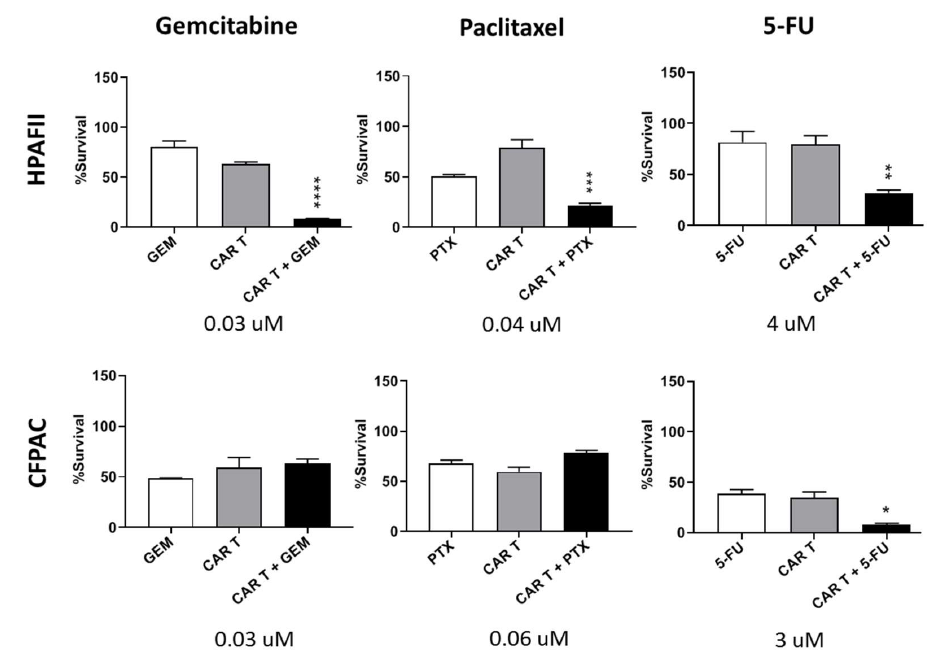
Figure 8. tMUC1-CAR T cells work synergistically with common chemotherapy drugs to kill resistant PDA cells. Percentage survival of two resistant PDA cells, HPAFII and CFPAC, treated with combination of CAR T and chemotherapy drugs. HPAFII and CFPAC were exposed to gemcitabine, paclitaxel, or 5-FU for 24 h at indicated concentrations, then co-cultured with mock or CAR T cells at T:E ratio of 1:10. The survival level was measured using MTT assay and data was normalized to mock T. Student’s t -test comparing CAR T + drug to CAR T alone group, * p < 0.05, ** p < 0.0021, *** p < 0.0004, **** p < 0.0001. Error bars, SEM. n = 4.